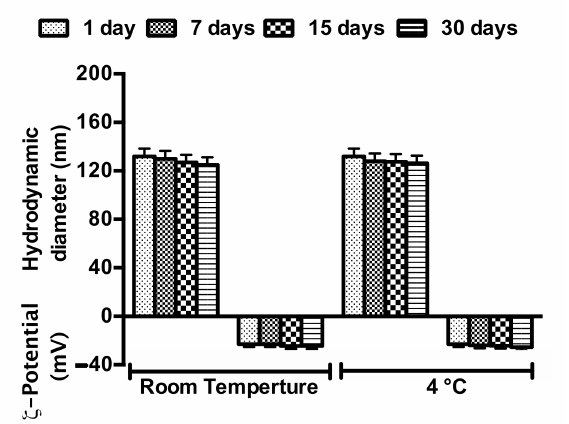
Figure 3. Stability studies of NR in terms of hydrodynamic diameter and ζ -potential up to 30 days at two different storage